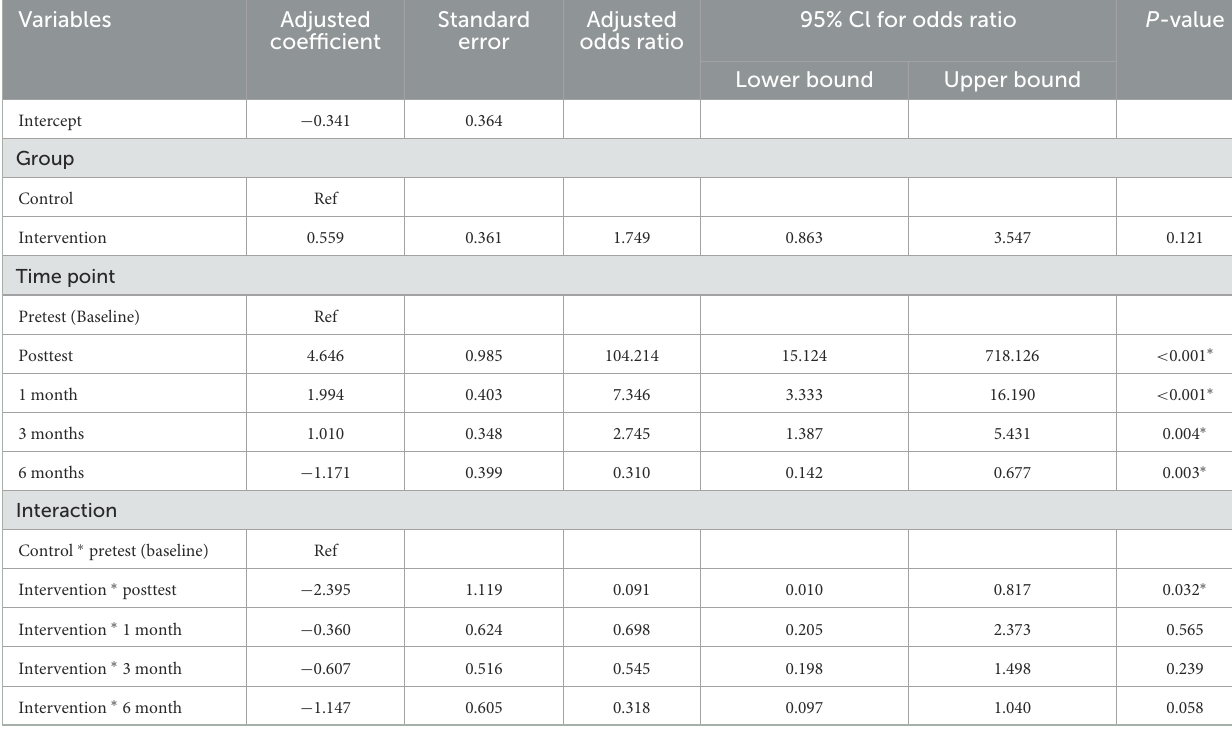
TABLE 3 Effectiveness of video self-instruction training (intervention group) and instructor-led (control group) between intervention and control group on CPR skills retention across time points (pretest, posttest, 1 month, 3 month, and 6 month), adjusted with